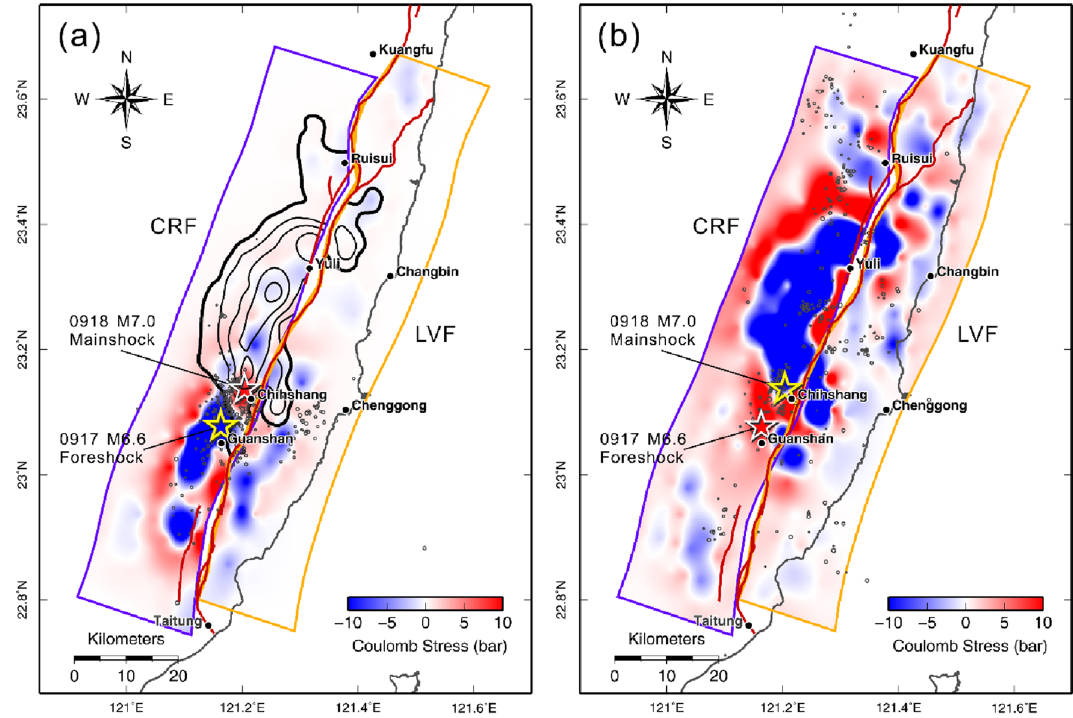
Figure 5. The Coulomb stress change caused by the 2022 Chihshang earthquake sequence. ( a ) The Coulomb stress change on the CRF and LVF that caused by the finite-fault source model of the 0917 foreshock. Black contours show the slip distribution of the mainshock. Events before 0918 mainshock are shown with open circles. The mainshock epicenter and most of the events before the mainshock are located in areas where △ CFS increased significantly. ( b ) The Coulomb stress change on the CRF and LVF that caused by the 0918 mainshock. Open circles are events that occurred after the mainshock. The map was generated by the GMT v.4.3.1 (https:// www. gener ic- mappi ng- tools.